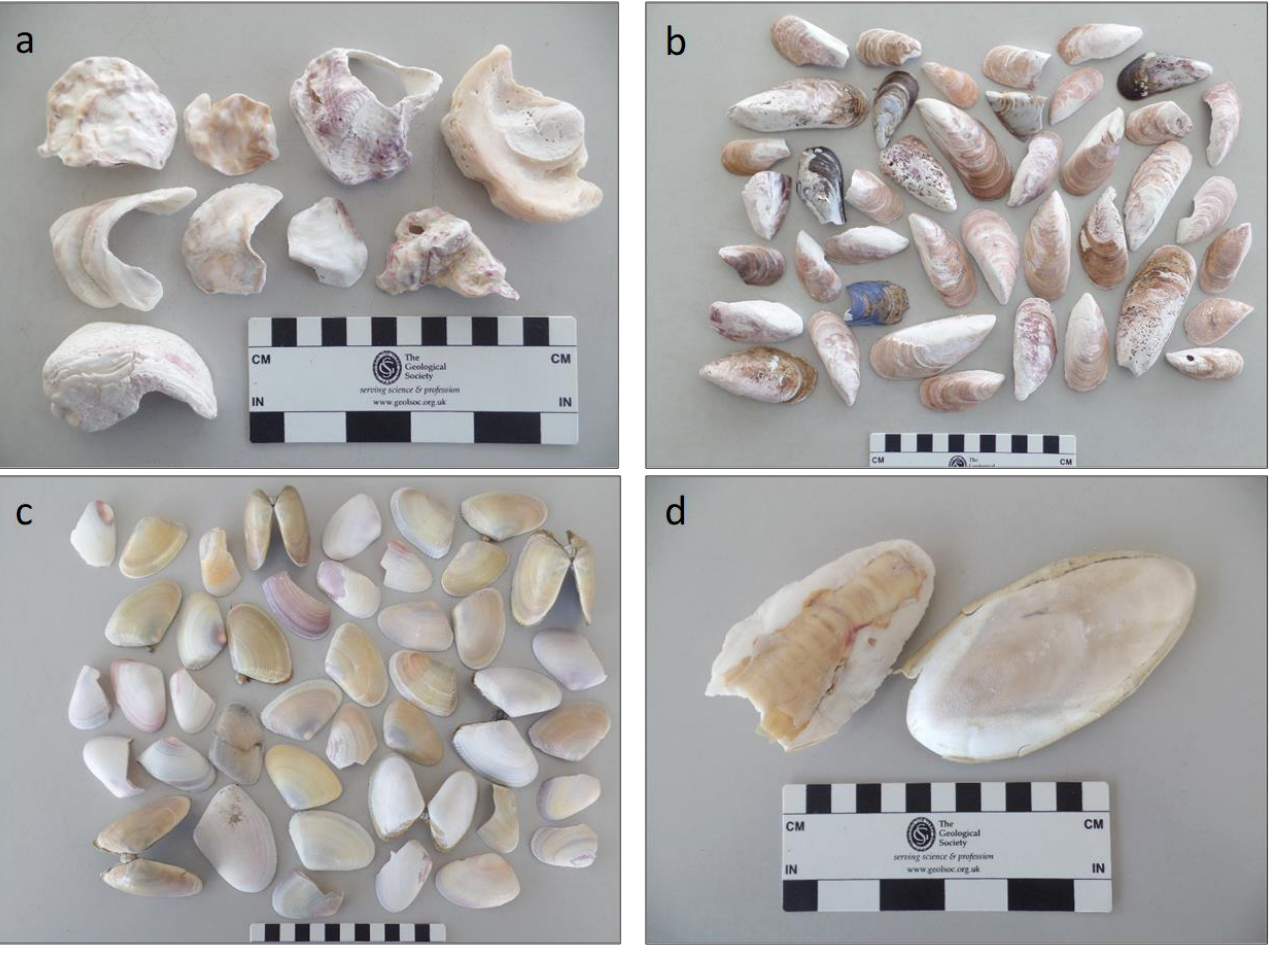
Figure 2. Shell samples collected from Oyster Bay. ( a ) Cape brooding oyster ( Ostrea atherstoni , sample 1); ( b ) Brown mussel ( Perna perna , sample 2); ( c ) Agulhas ridged nut clam ( Lembulus belcheri , sample 3); ( d ) Southern cuttlefish ( Sepia australis , sample 4).